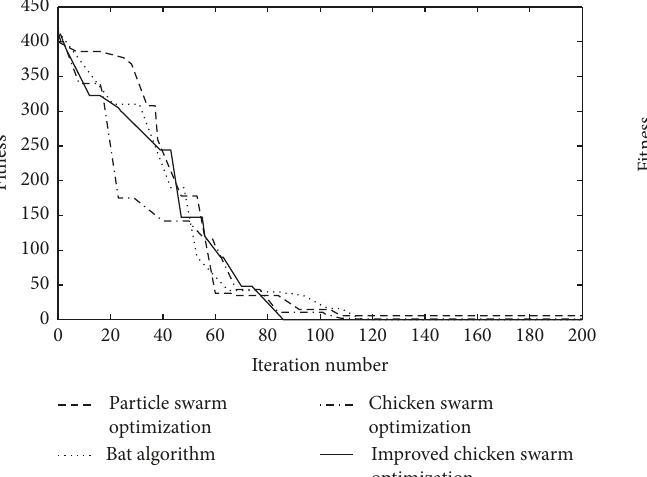
( x ) with 30 dimensions. 4